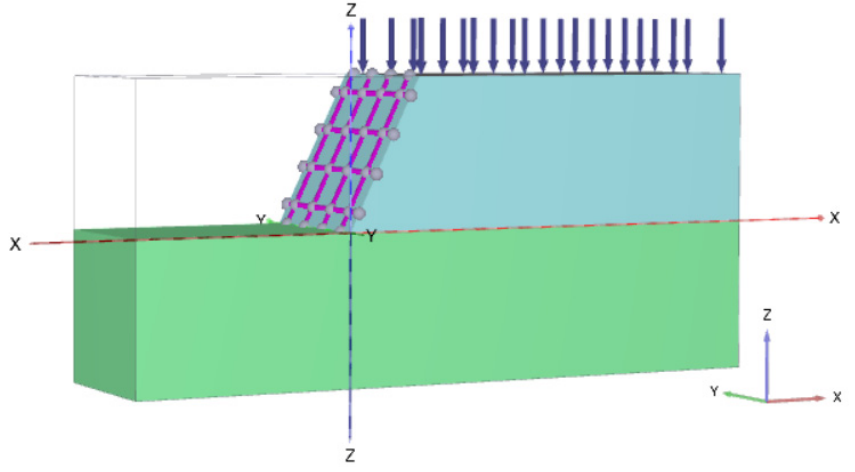
Figure 19. The 1:0.5 model of filled-slope reinforced by a frame with prestressed anchor-plates.